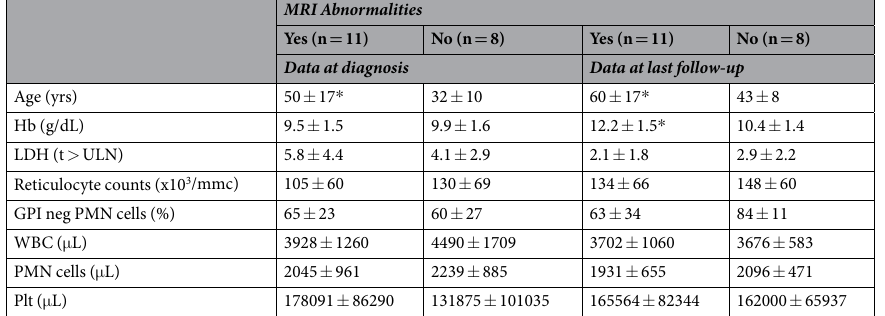
Table 2. Clinical and hematological parameters of patients with or without MRI abnormalities. Values are expressed as mean ± SD; * denotes p < 0.05, MRI abnormalities versus no MRI